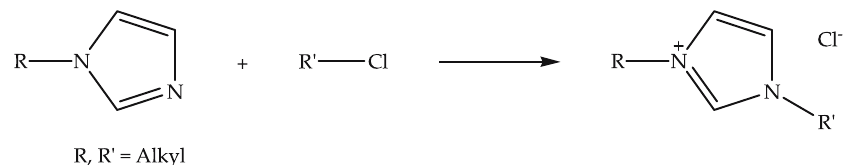
Figure 3: Schematic representation of the alkylation reaction of N - alkylimidazole with alkyl chloride to synthesize the N - alkyl - N - alkylimi - dazolium chloride ionic liquid.